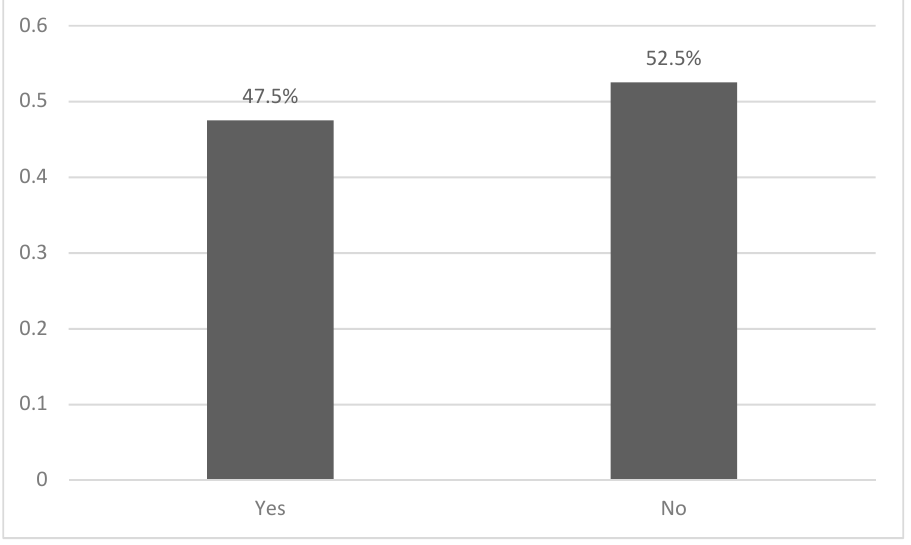
Table 3. Contingency coefficients (Pearson’s coefficient) for using environmental criteria in everyday life, awareness of SRI, and pro-ecological decisions vs. individual characteristics of respondents. VARIABLE